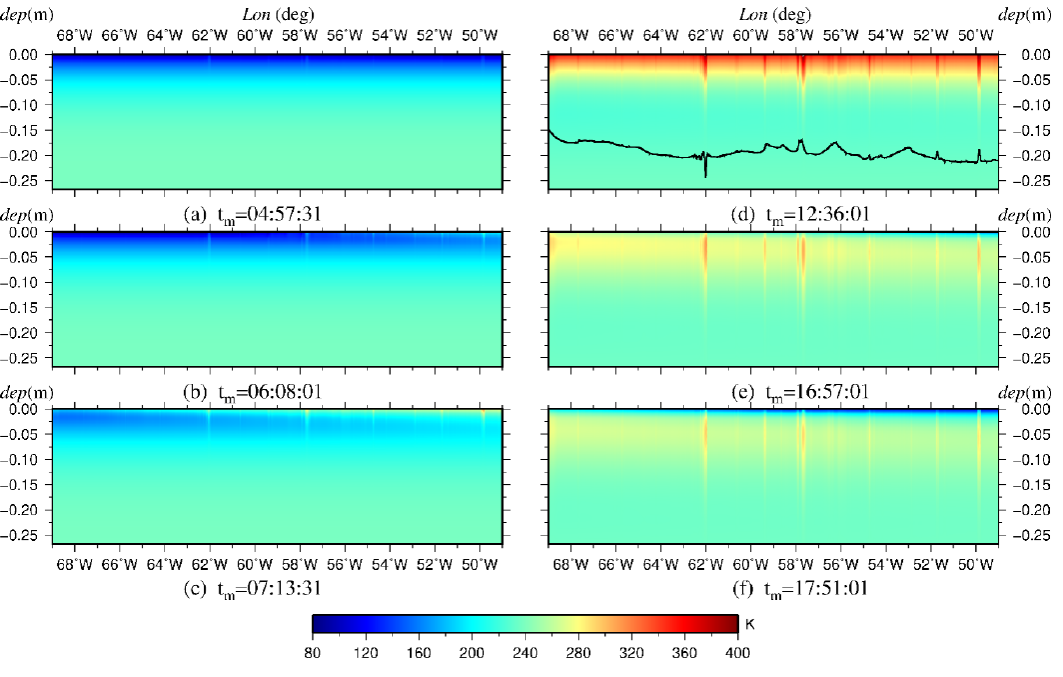
Figure 8. Temperature variation along the latitude direction. ( a ) UTC 2020-0-3T17:15:01; ( b ) UTC 2020-05-05T04:30:01; ( c ) UTC 2020-05-06T13:15:01; ( d ) UTC 2020-05-13T06:30:01; ( e ) UTC 2020-05- 18T17:00:01; ( f ) UTC 2020-05-19T20:00:01. The black line in Figure 8d denotes the surface topography with fixed latitude 43.68 ° N but varied longitude. t m represents the lunar local time.